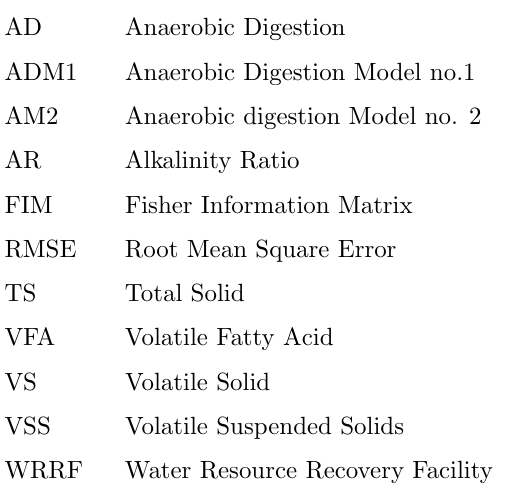
The abbreviations are in alphabetical